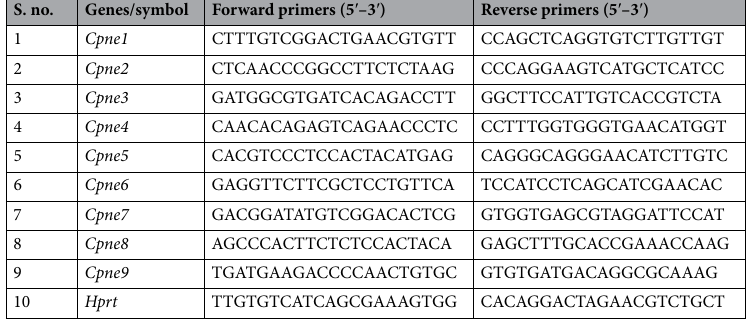
Table 1. Sequences of SYBR-Green PCR